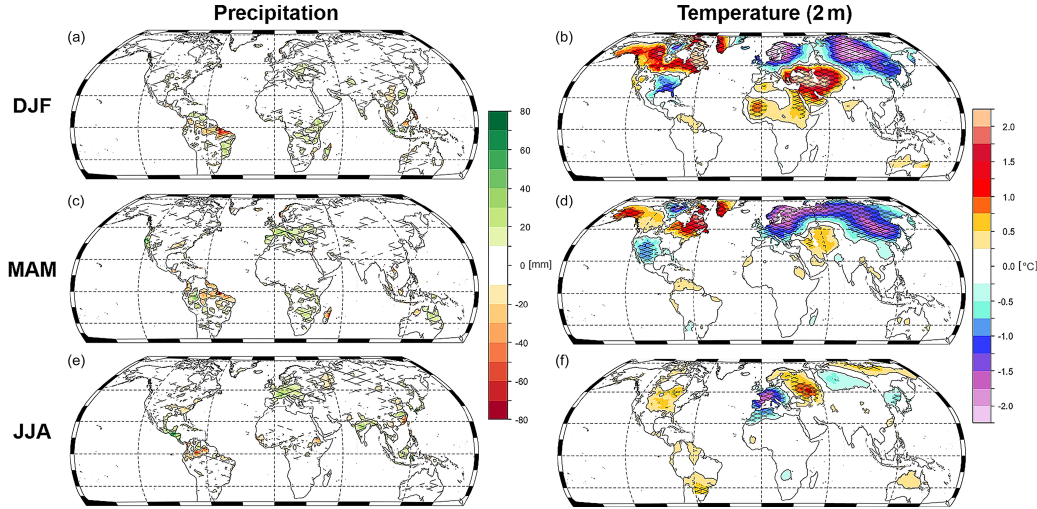
Figure 6. Composite maps (high − low) for precipitation and air temperature related to the first δ 18 O component for the DJF, MAM, and JJA seasons. Panels (a) and (b) show the characteristics of the climate in DJF, panels (c) and (d) show the characteristics of the climate in MAM, and panels (e) and (f) show the characteristics of the climate in JJA. The results for precipitation (a, c, e) and air temperature (b, d, f) are also given. The precipitation and air temperature dataset from CRU TS is included in this figure for the period from 1901 to 2005. The significance is shown using a black grid overlay.